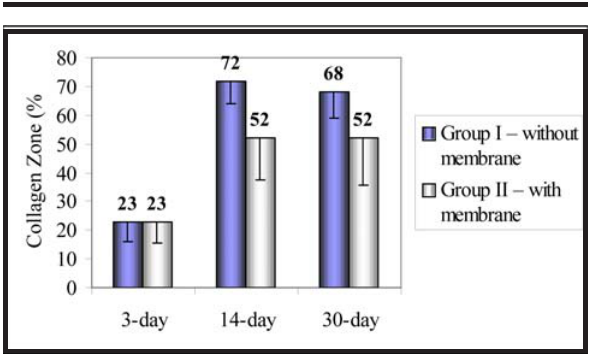
FIGURE 4 - Quantified distribution of the collagen zone (Mean-SD), in percentages, as determined using image analysis